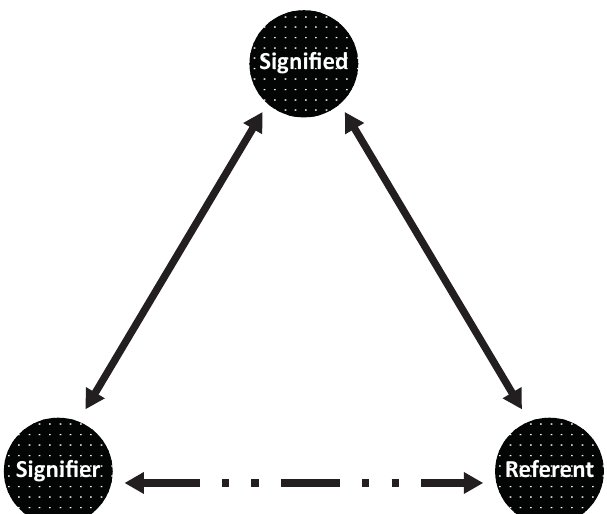
Figure 2. The Semiotic Triangle constituted relationally by the ‘referent,’ the ‘signifier,’ and the ‘signified.’ Urban Planning, 2021, Volume 6, Issue 1, Pages